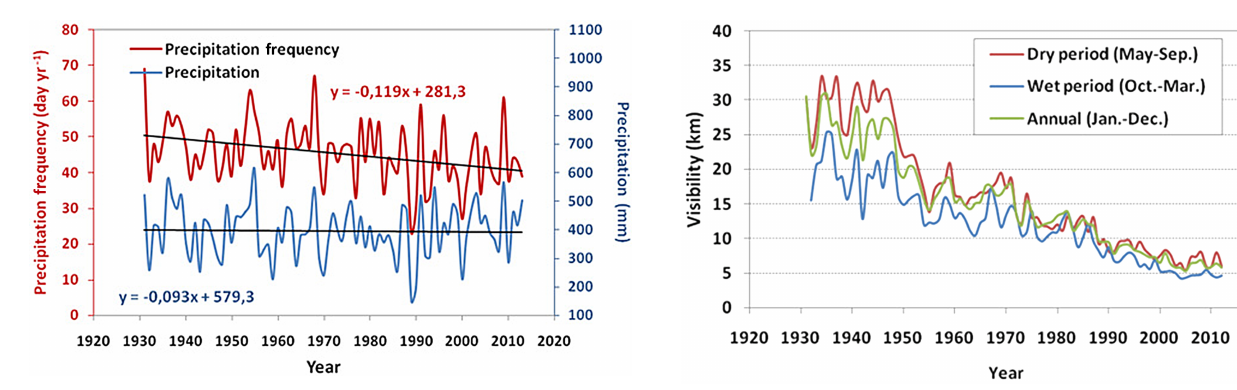
Figure 8. Variation of visibility at NOA from 1931–2013 during the dry (May–September), wet (October–March) and all year (January– December)